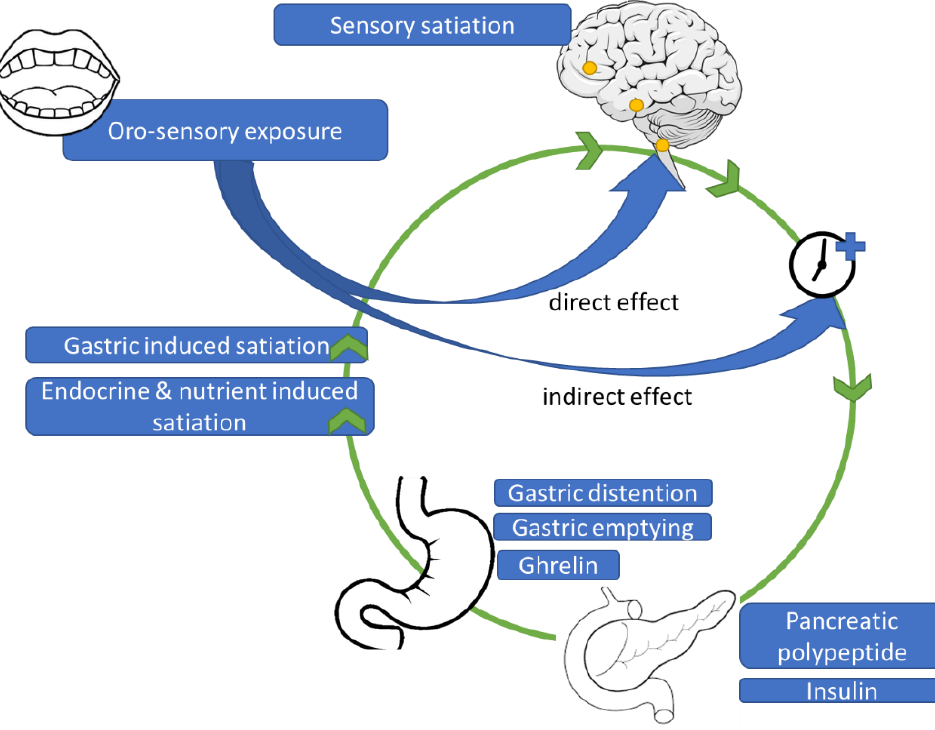
Figure 4. Proposed physiological mechanism underlying effects of oro-sensory exposure on satia- tion.